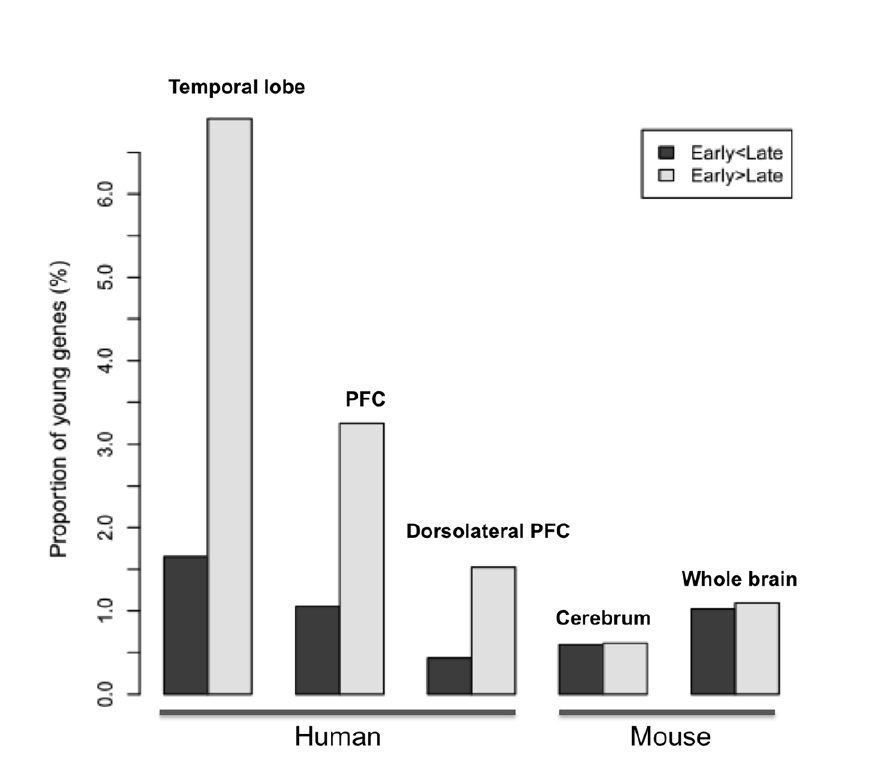
Figure 2. Proportion of young genes out of all genes differentially expressed between developmental stages. For all samples, we compared two developmental stages, identified differentially expressed genes, and then plotted the proportion of young genes out of all early stage or late stage biased genes (Methods). The temporal lobe (one part of the neocortex) and cerebrum data compared fetal and adult brains, while the other three datasets compared infant with subsequent stages (Tables S1,